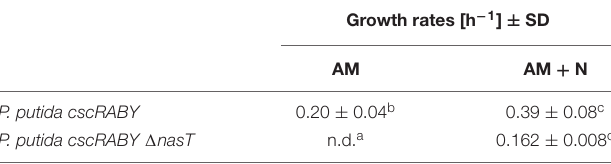
TABLE 2 | Growth rates of P. putida cscRABY and P. putida cscRABY (cid:49) nasT on